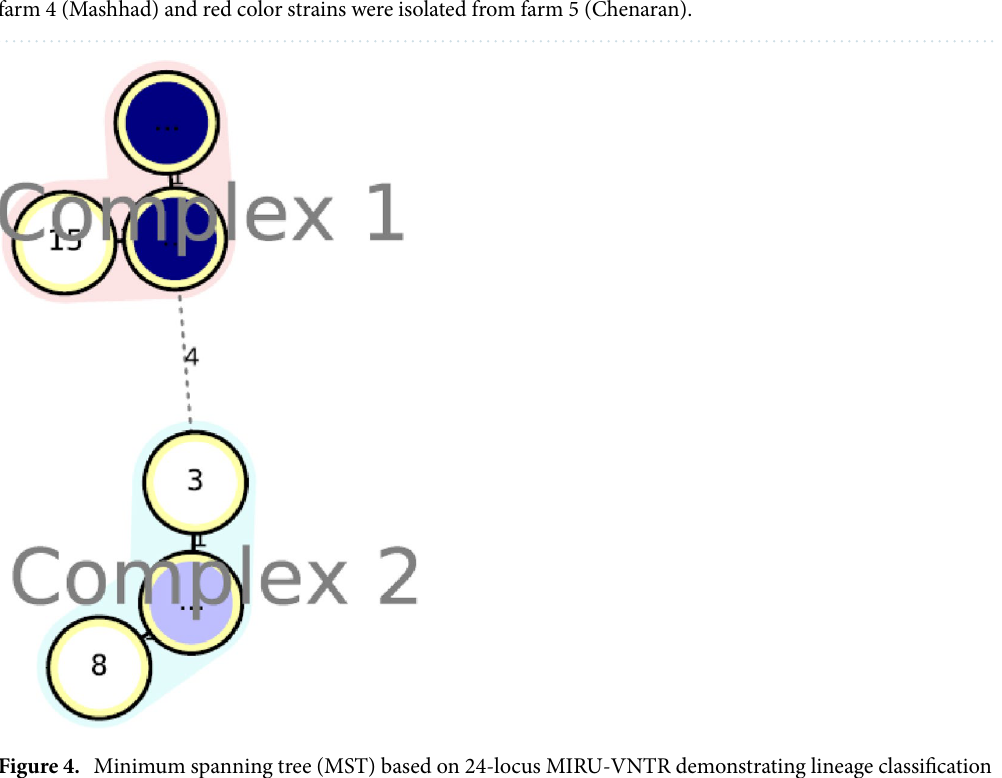
Figure 3. UPGMA tree showing genetic relatedness of 21 Mycobacterium bovis isolates from Khorasan Razavi province based on the 24-locus MIRU-VNTR. Genotype and copy numbers are mentioned for each isolate along with the dendrogram The arrangement of MIRU-VNTR loci from left to right including: MIRU 02, Mtub04, ETR C, MIRU 04, MIRU 40, MIRU 10, MIRU 16, Mtub21, MIRU 20, QUB-11b, ETR A, Mtub29, Mtub30, ETR B, MIRU 23, MIRU 24, MIRU 26, MIRU 27, Mtub34, MIRU 31, Mtub39, QUB-26, QUB-4156, MIRU 39. Violent color strains were isolated from farm1 (Mashhad), blue color strains were isolated from farm